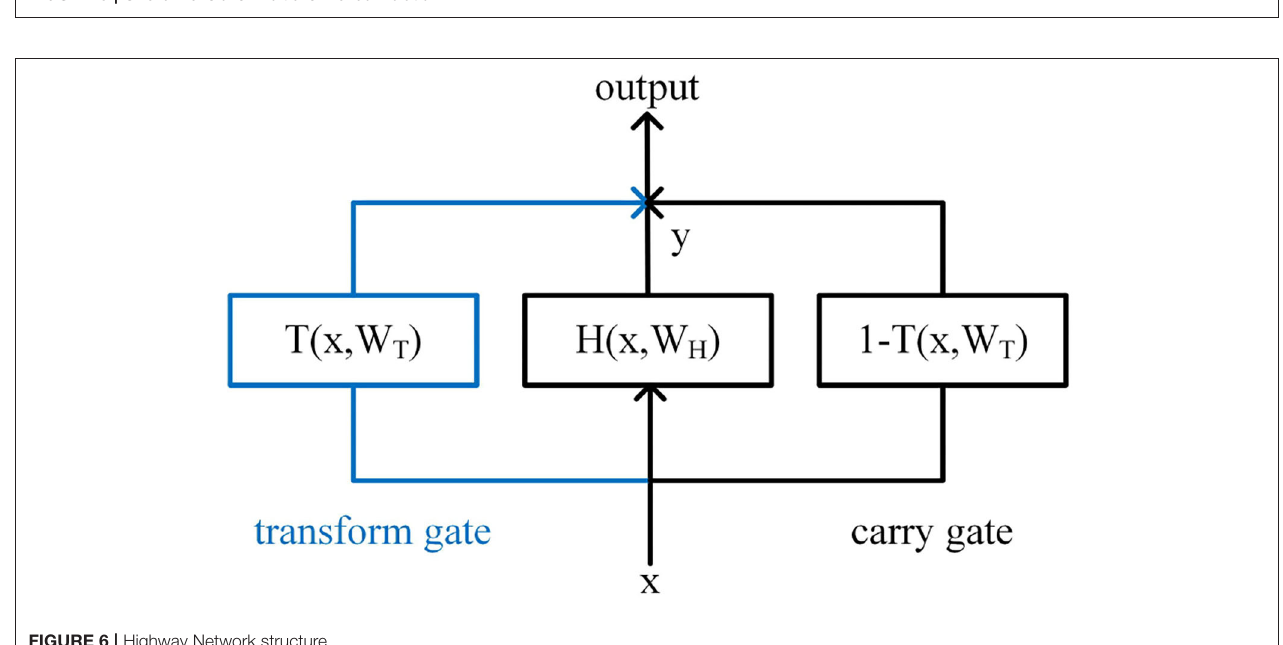
FIGURE 6 | Highway Network